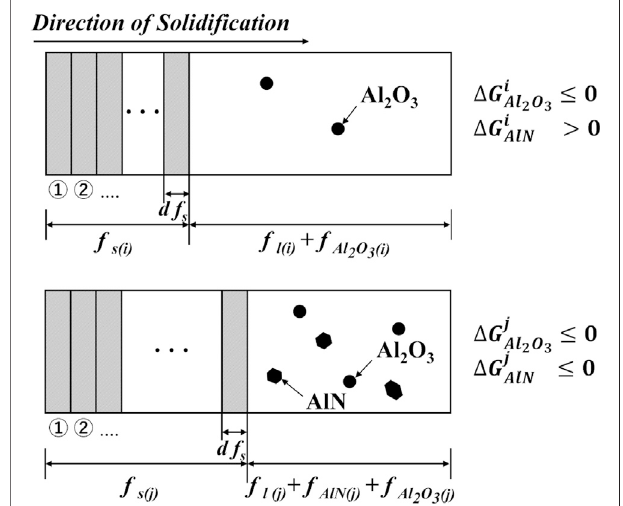
FIGURE 8 | A schematic illustration of the microsegregation model.